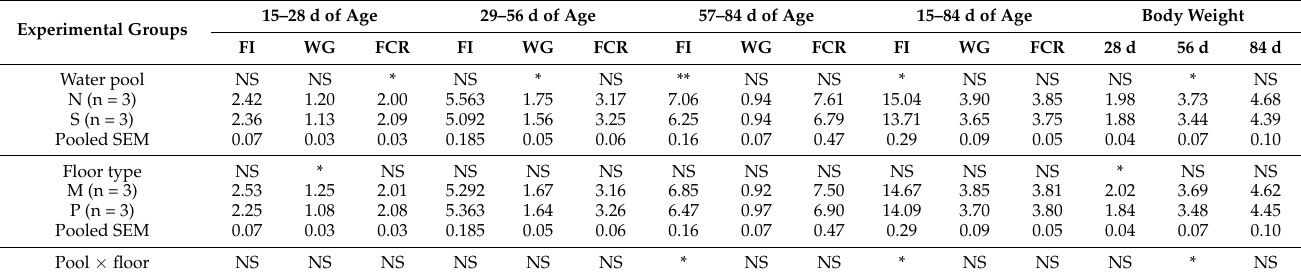
Table 2. Effects of different floor types and pool conditions on growth performance in White Roman geese. Experimental